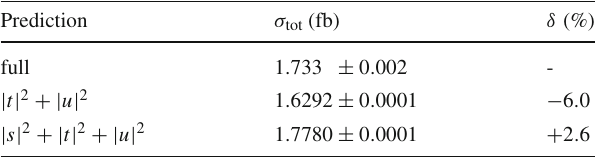
Table 4 Cross sections at NLO QCD i.e. at order O (α s α 6 ) for the full computation and two approximations. In addition to the cuts of Sect. 3.3, the VBS cuts take the values m jj > 200GeV and | Δ y jj | >